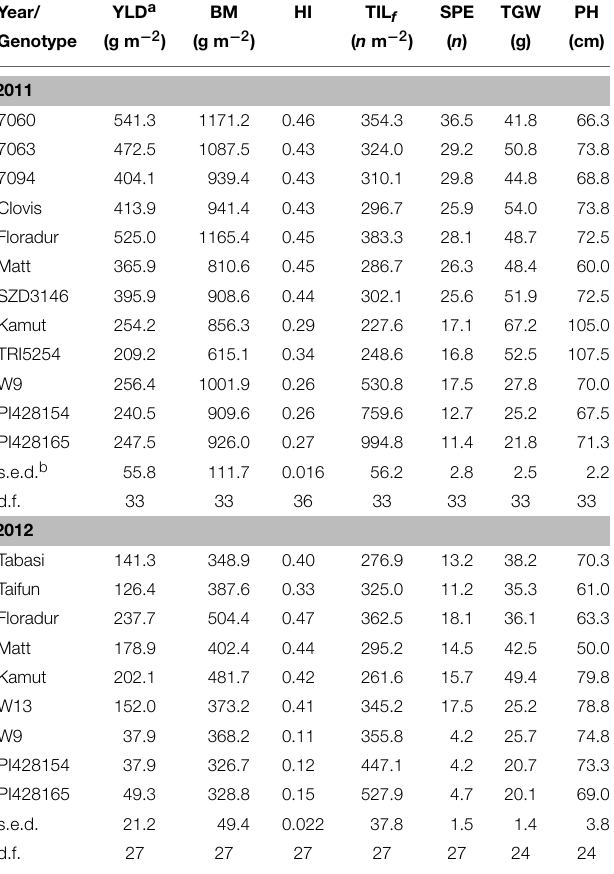
TABLE 2 | Genotypic mean values of grain yield and yield components in 2011 and